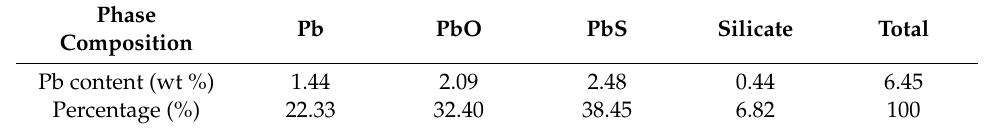
Table 4. Lead phase composition of the lead refining dross.